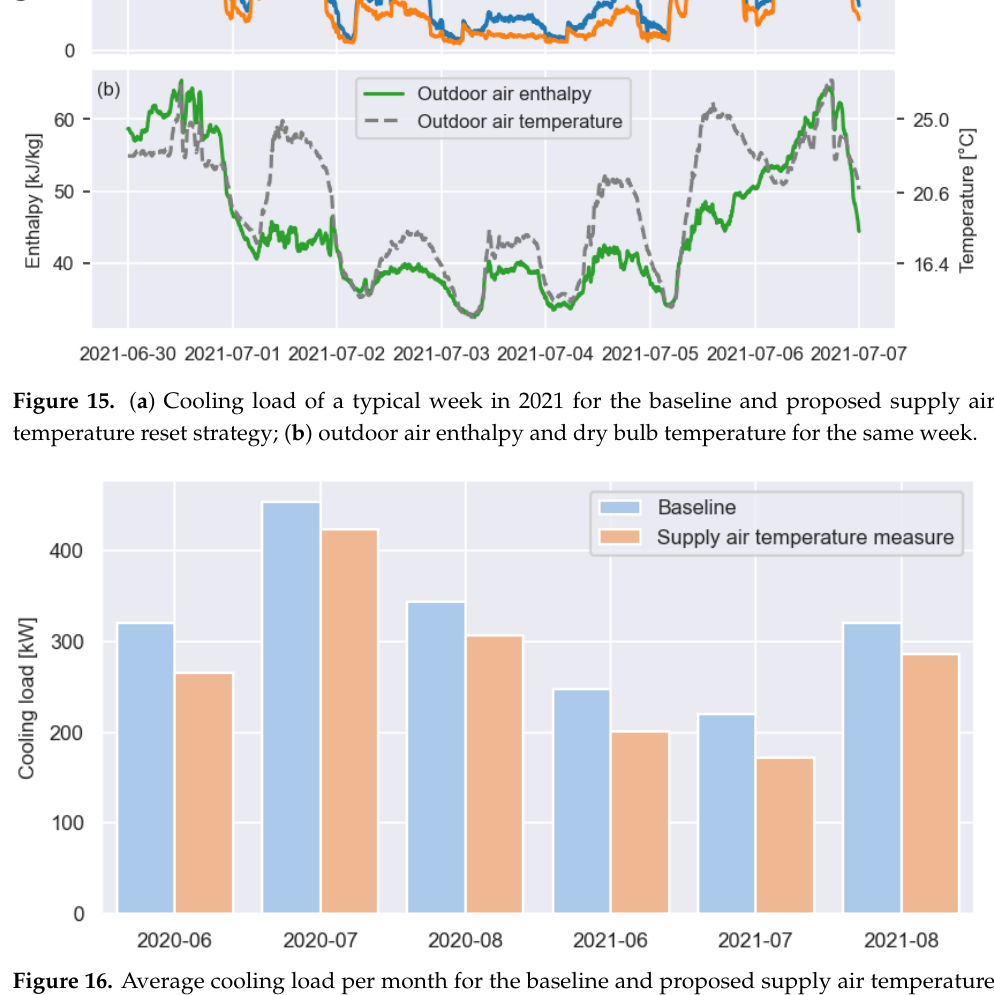
Figure 15. ( a ) Cooling load of a typical week in 2021 for the baseline and proposed supply air tem- perature reset strategy; ( b ) outdoor air enthalpy and dry bulb temperature for the same week.